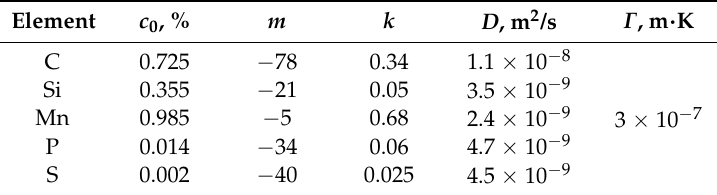
Table 2. Composition, liquidus slope, solute partition coefficient, diffusion coefficient, and Gibbs- Thompson coefficient of binary Fe- X steels.